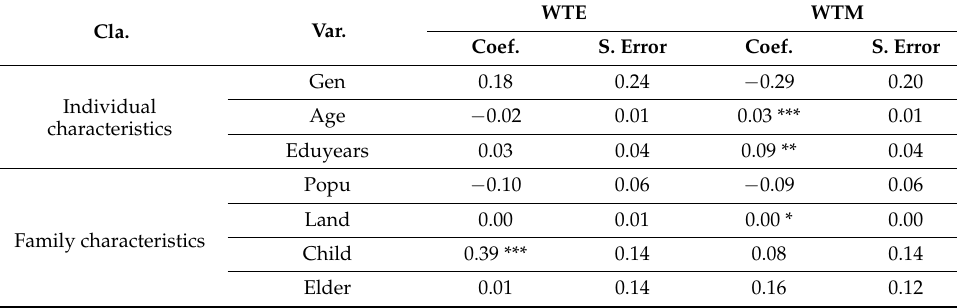
Table 3. Measurement